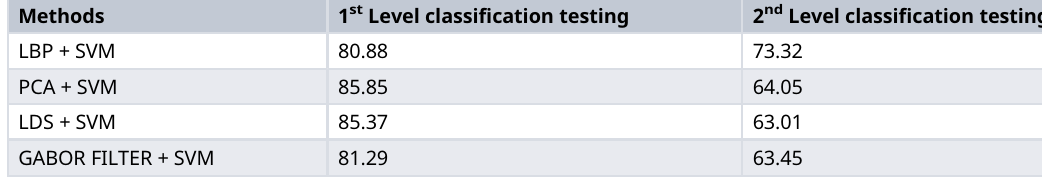
Table 3. Experimental results of SVM variants.